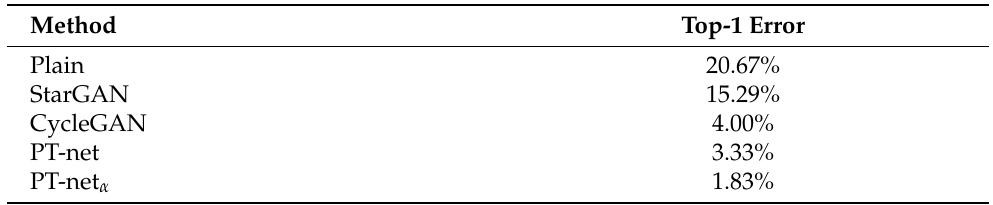
Table 3. Results of NIR2Blue recognition. PT-net α refers to PT-net trained with aligned data, intro- duced in Section 4.3.